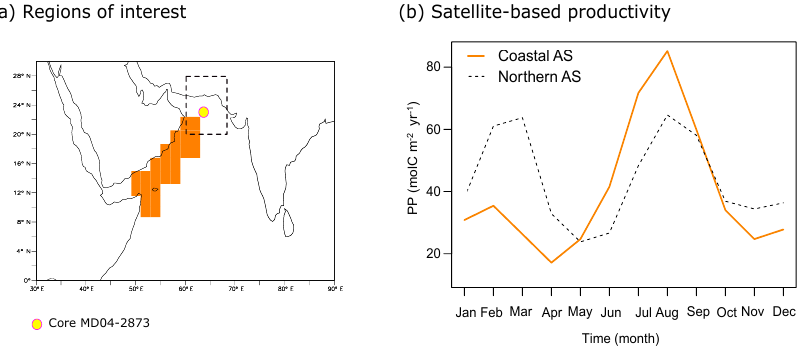
Figure 2. (a) Coastal (orange shading) and northern (black dotted contour) Arabian Sea areas, position of core MD04-2873 (yellow circle) and (b) seasonal cycles of current-day productivity in the coastal (bold orange line) and northern (black dashed line) Arabian Sea. Productivity data come from the SeaWiFS satellite data for the period 1998–2005 (Lévy et al.,